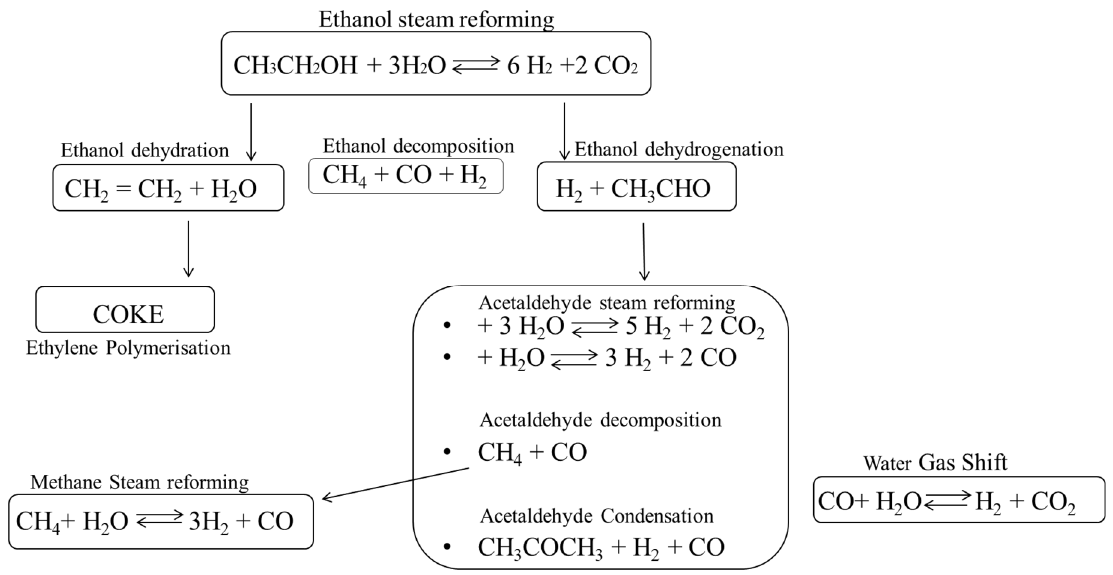
Figure 1. Reaction pathways involved in the ethanol steam reforming (ESR) process.